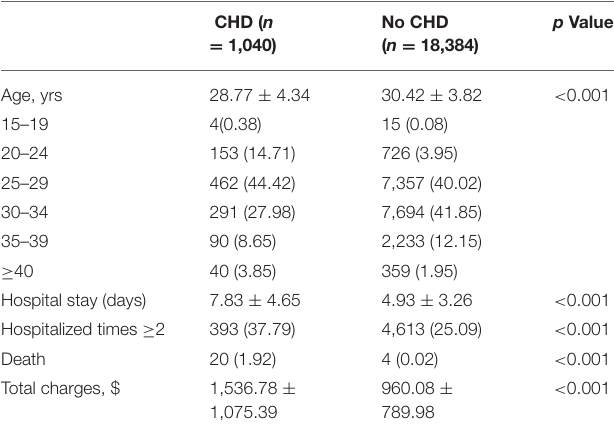
TABLE 1 | Demographic characteristics of women with and without CHD admitted for delivery, 2010 to